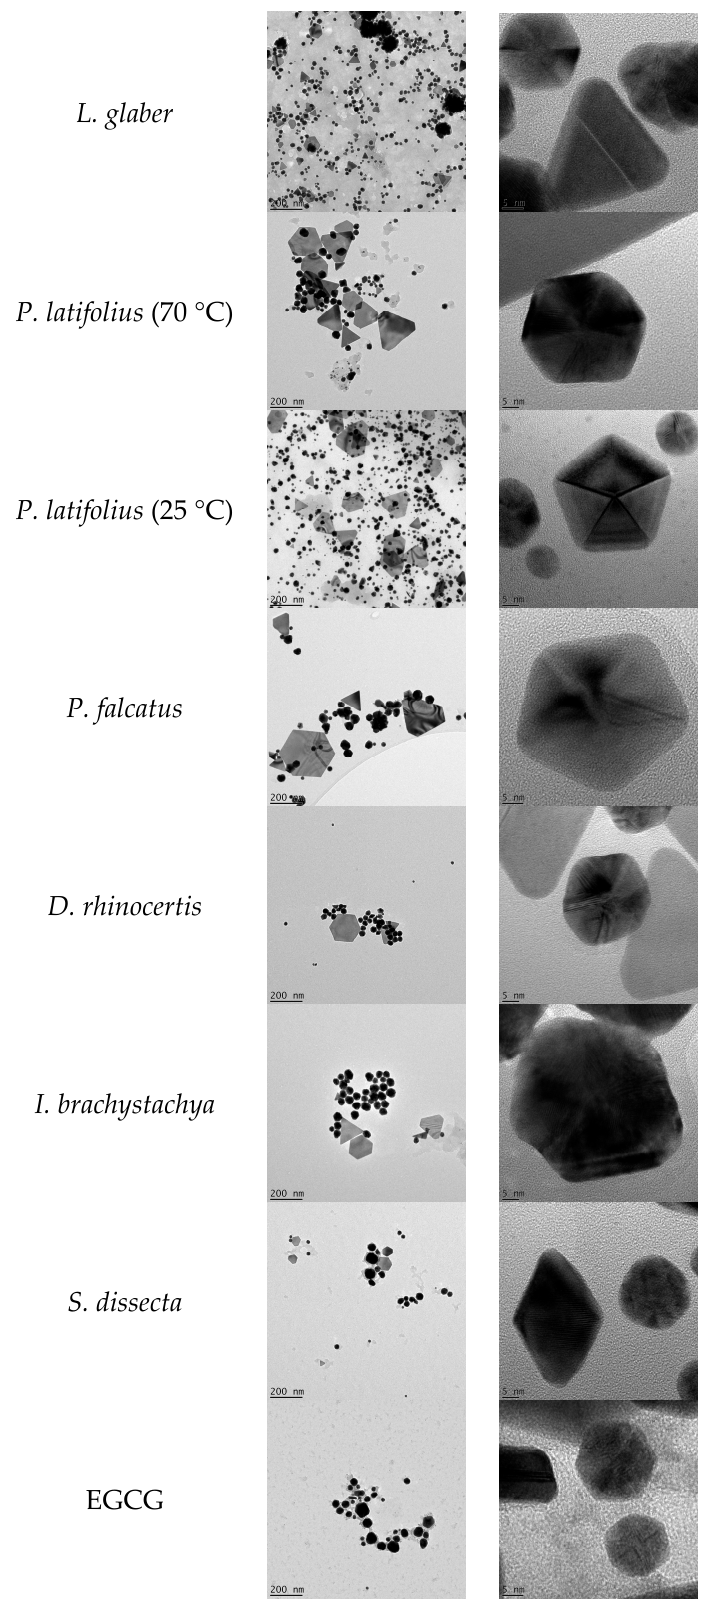
Figure 2. Transmission Electron Microscopy (TEM) images of the synthesized AuNPs.